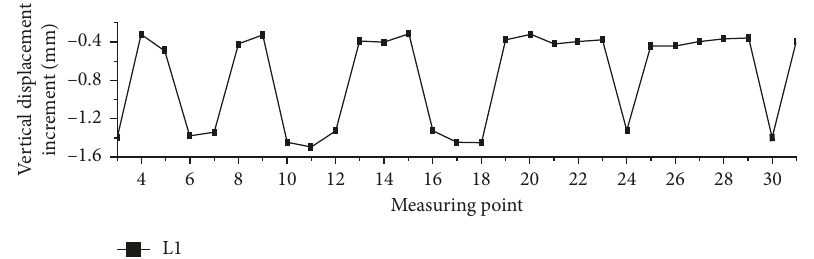
Figure 9: Vertical displacement observation of line